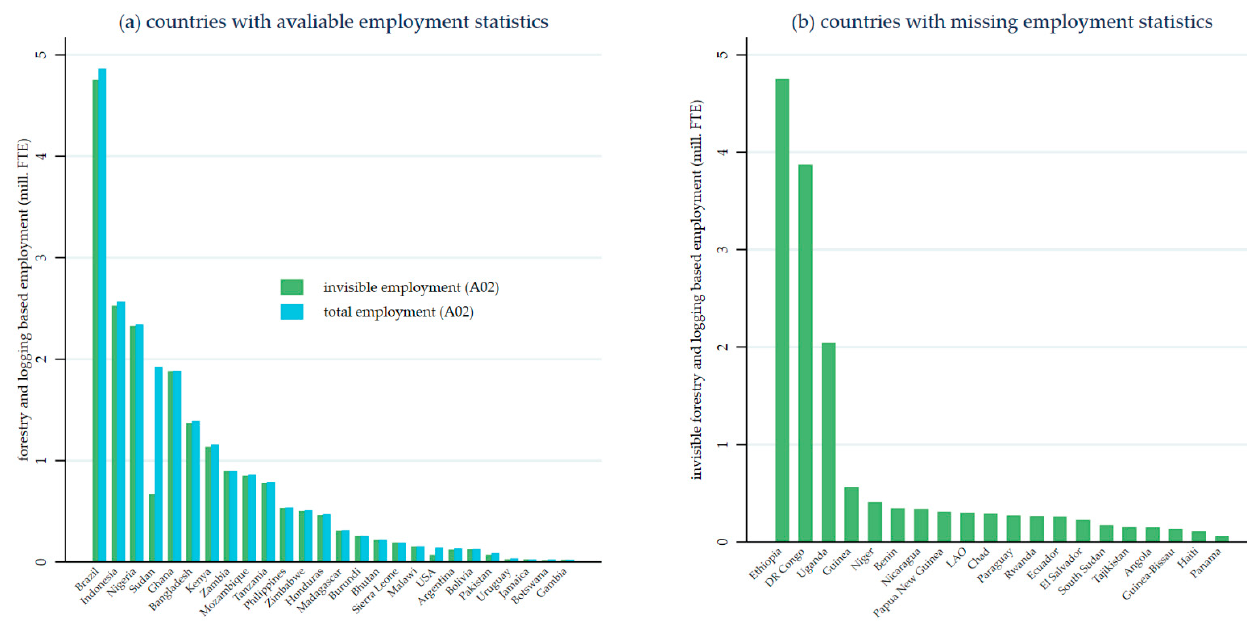
Figure 4. Visible and invisible employment in the forestry and logging sub-sector of selected countries with ( a ) for countries with available employment statistics, ( b ) for countries without employment statistics. Notes: Total employment in ( a ) is the aggregation of visible employment in the forestry and logging sub-sector compiled by FRA 2020 and our invisible employment estimates at the lower-bound. The invisible employment number in ( b ) is the lower-bound estimates.